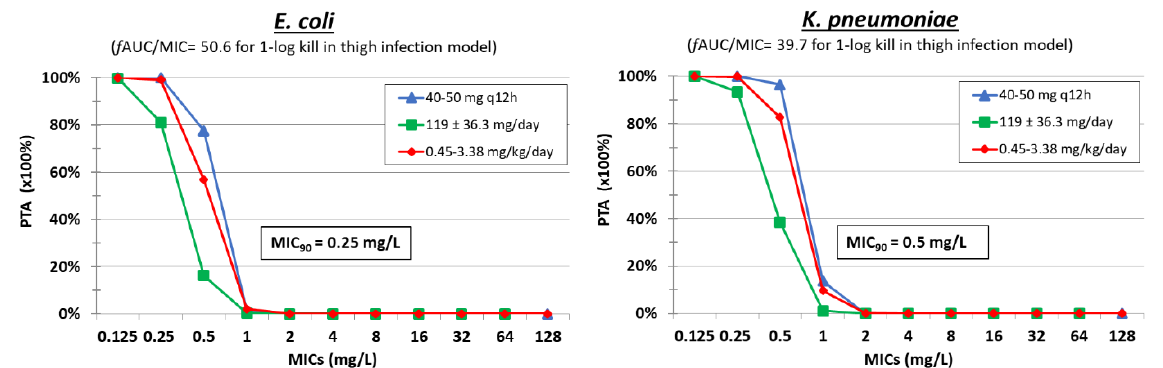
Figure 2. Probability of target attainment (PTA) of polymyxin B at different dosing regimens against isolates with increasing MIC.